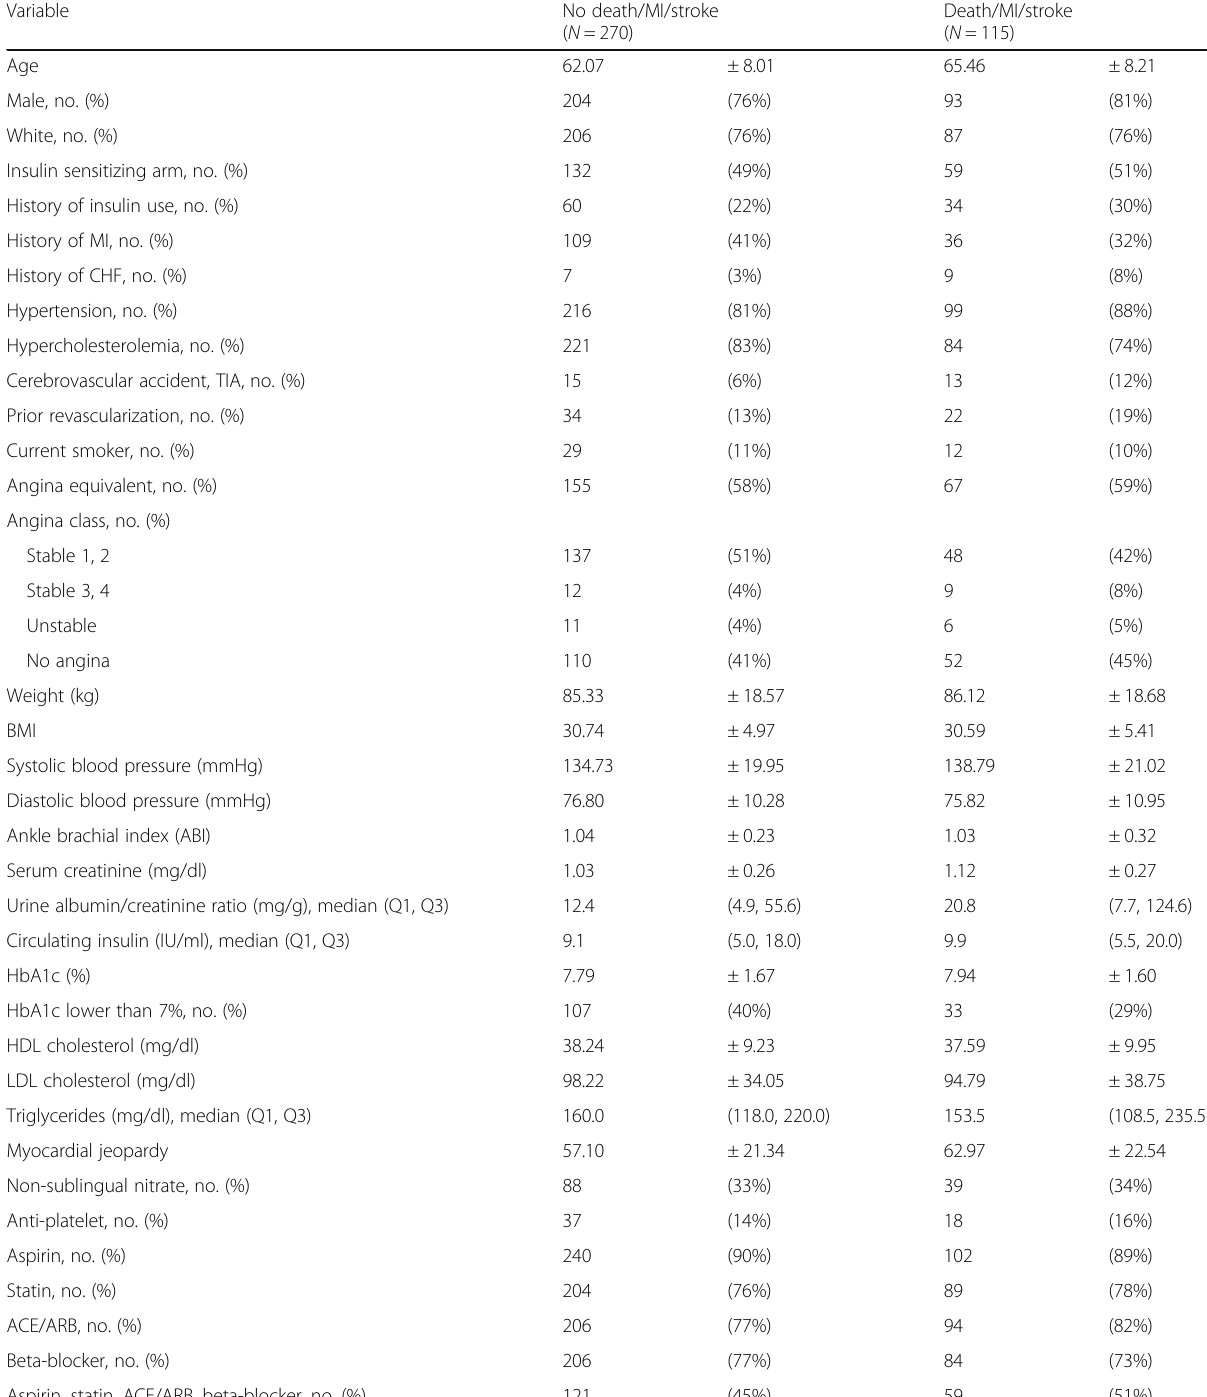
Death/MI/stroke ( N = 270) ( N = 115)